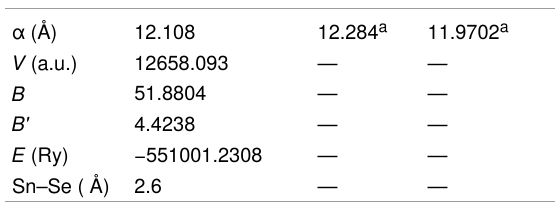
Table 1: Lattice parameters for the π -SnSe phase of a 64-atom unit cell. The values of bulk modulus ( B in GPa) and the derivative of bulk modulus ( B' ), volume ( V in a.u. 3 ), and bond length of Sn–Se (Å) are given below.